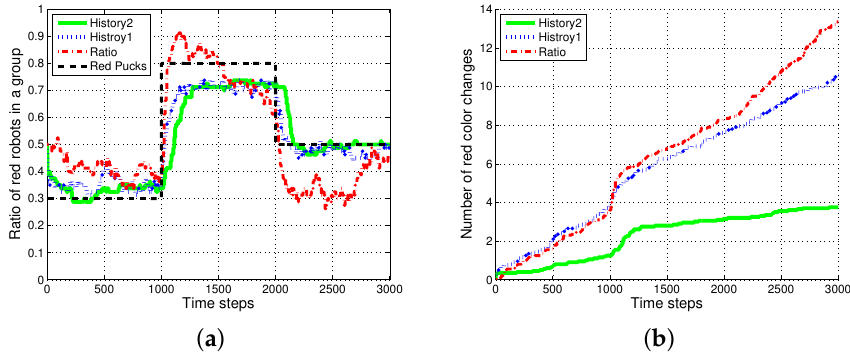
Figure 15. Ratio of robots foraging for red pucks in a group, and the number of task switches for red pucks. ( a ) Robots for red pucks in a group; ( b ) number of task switches for red